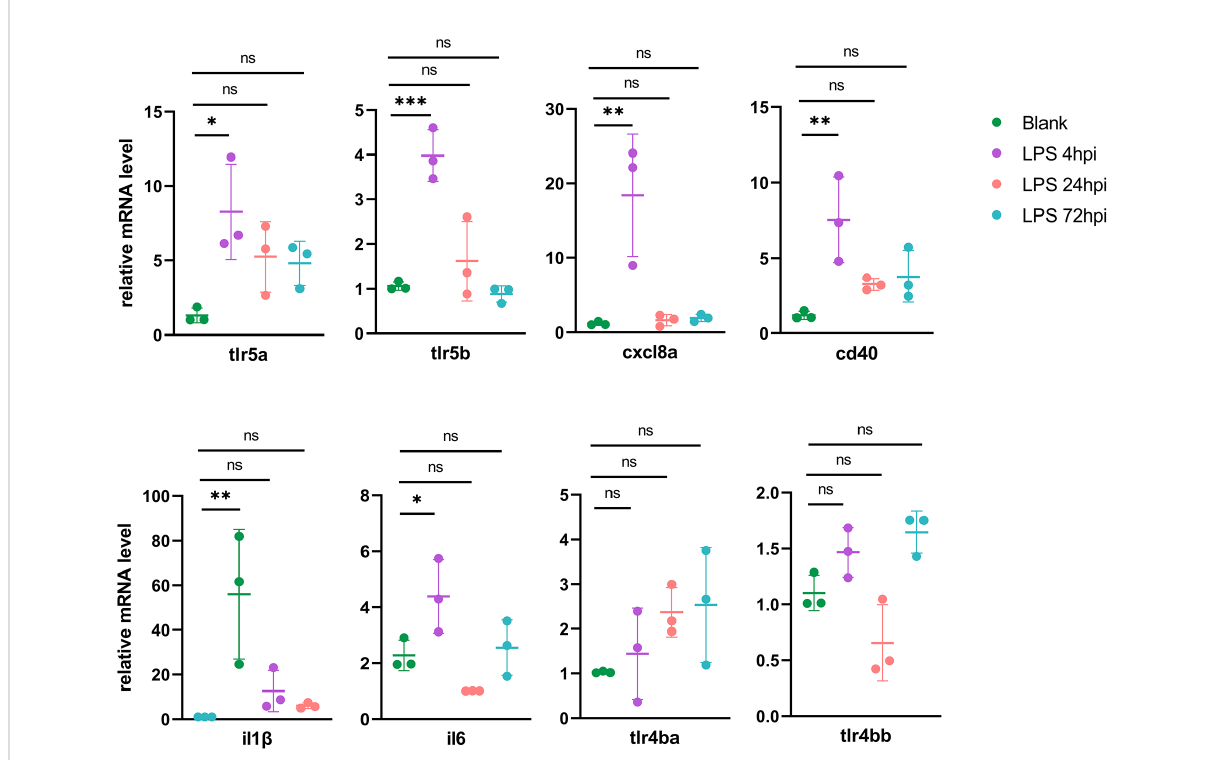
FIGURE 4 RT-PCR validation of DEGs in the initial of in fl ammation (mean ± SD; * P < 0.05, ** P < 0.01, *** P < 0.001, ns, not signi fi cant; one-way